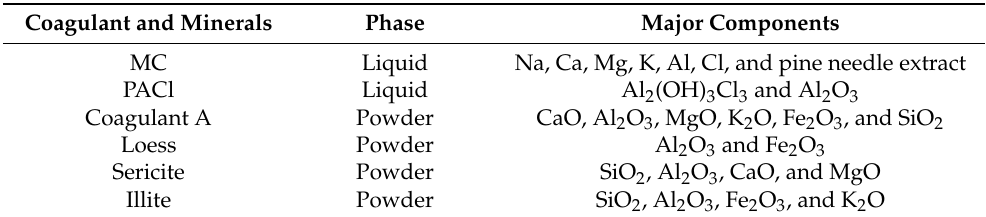
Table 2. Major compositions of coagulants and minerals used in the study. Coagulant and